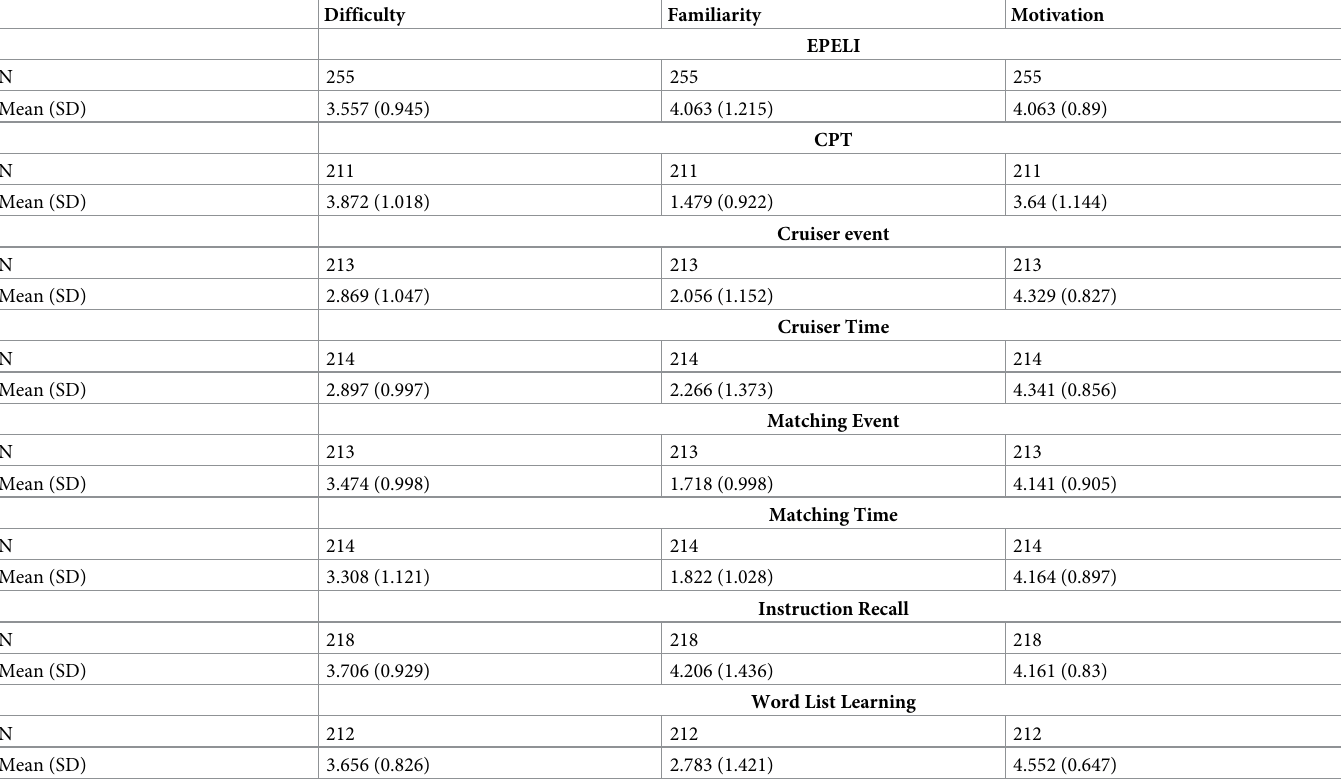
Table 5. Self-rated difficulty, familiarity, and motivation in the